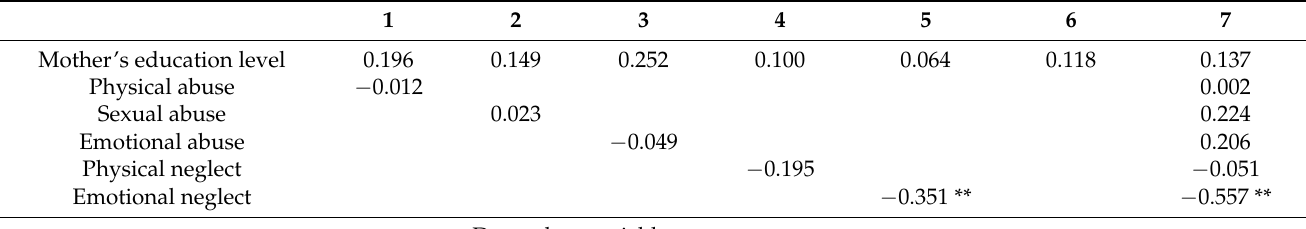
Table 6. Linear regression models using the encouragement domain as dependent